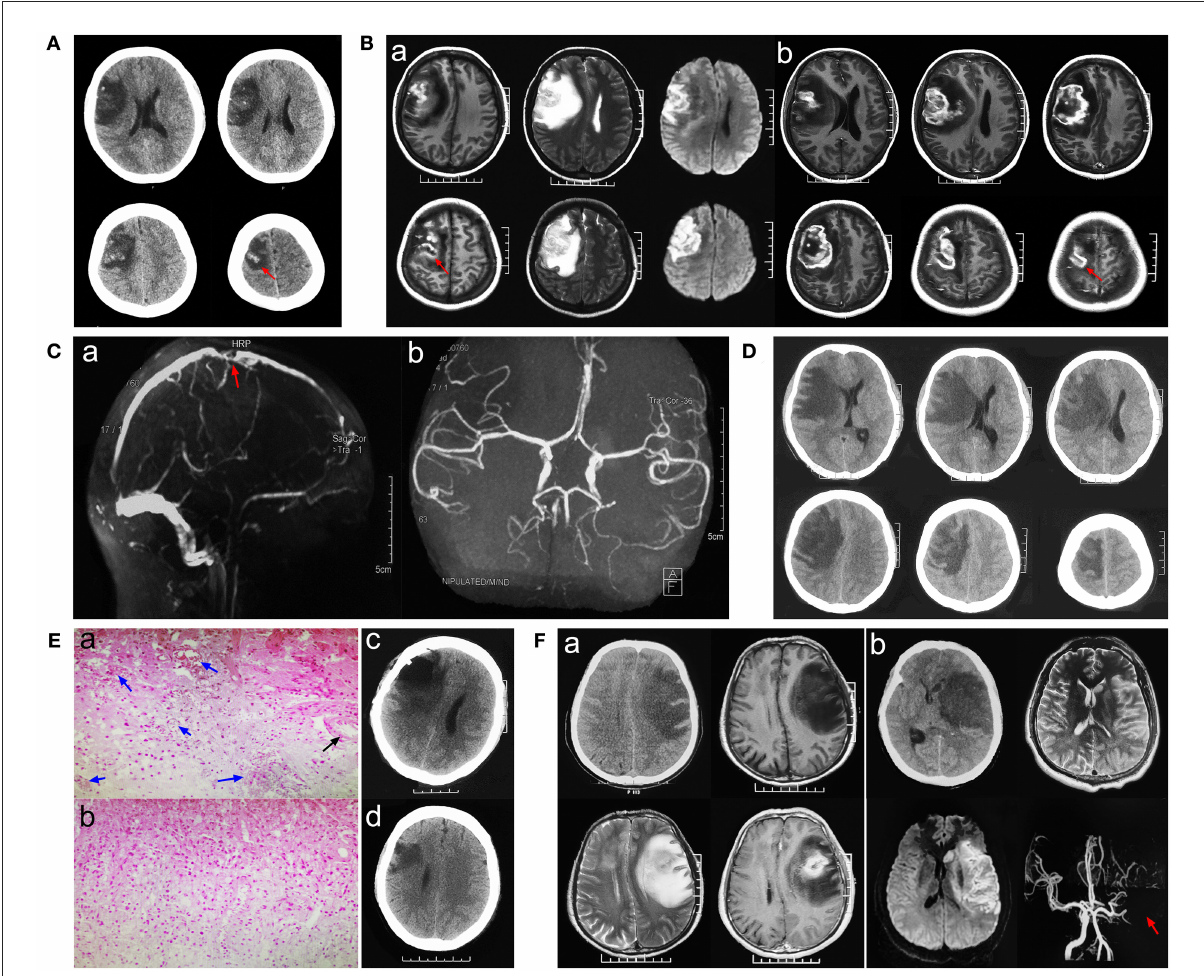
FIGURE1 Pathological neuroimaging studies per case showed evidence of venous infarction secondary to cortical venous thrombosis (CVT). (A) Initial stage computed tomography (CT) showed hypodensity with some hyperdensity in the right frontal–parietal lobes. (B a ) Magnetic resonance imaging (MRI) showed low-intensity signals mixed with high-intensity signals on T1-weighted images and high-intensity signals mixed with low-intensity signals on T2-weighted images in the right frontal–parietal lobes. (B b ) Contrast-enhanced MRI revealed focal circular heterogeneous enhancement of the lesion. (C a ) Magnetic resonance venography (MRV) showed cortical veins, and the corresponding parts of the superior sagittal sinus were sporadically visualized, which indicated CVI. (C b ) Magnetic resonance angiography (MRA) showed that the main arteries and their branches were normal. (D) Progressive CT showed expanded edema and a significant shift in the midline. (E a,b ) Histopathologic analysis revealed dilated small veins with congestion or thrombosis (blue arrow), while normal arterial structure and lumen (black arrow) and focal necrosis and inflammatory infiltration (green arrow) were found. (E c ) CT showed that part of the necrotic tissue was removed 24h post-operatively. (E d ) Three-month follow-up post-operatively. (F a ) A case of glioblastoma was confirmed by pathology. (F b ) Imaging characters in a case of middle cerebral artery